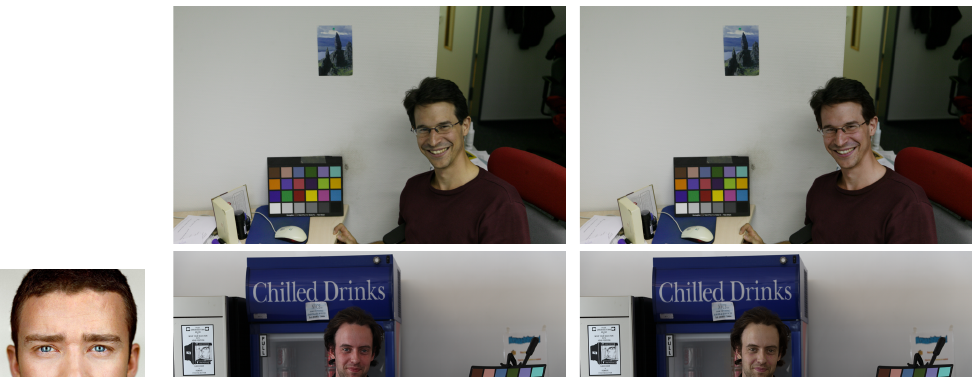
(c) Output Figure 7. Our facial skin color correction. ( a ) target facial skin color image; ( b ) input image, and ( c ) output image using our facial skin color correction. The target image is in Shin et al.’s dataset [13] and the input images are in the Gehler dataset